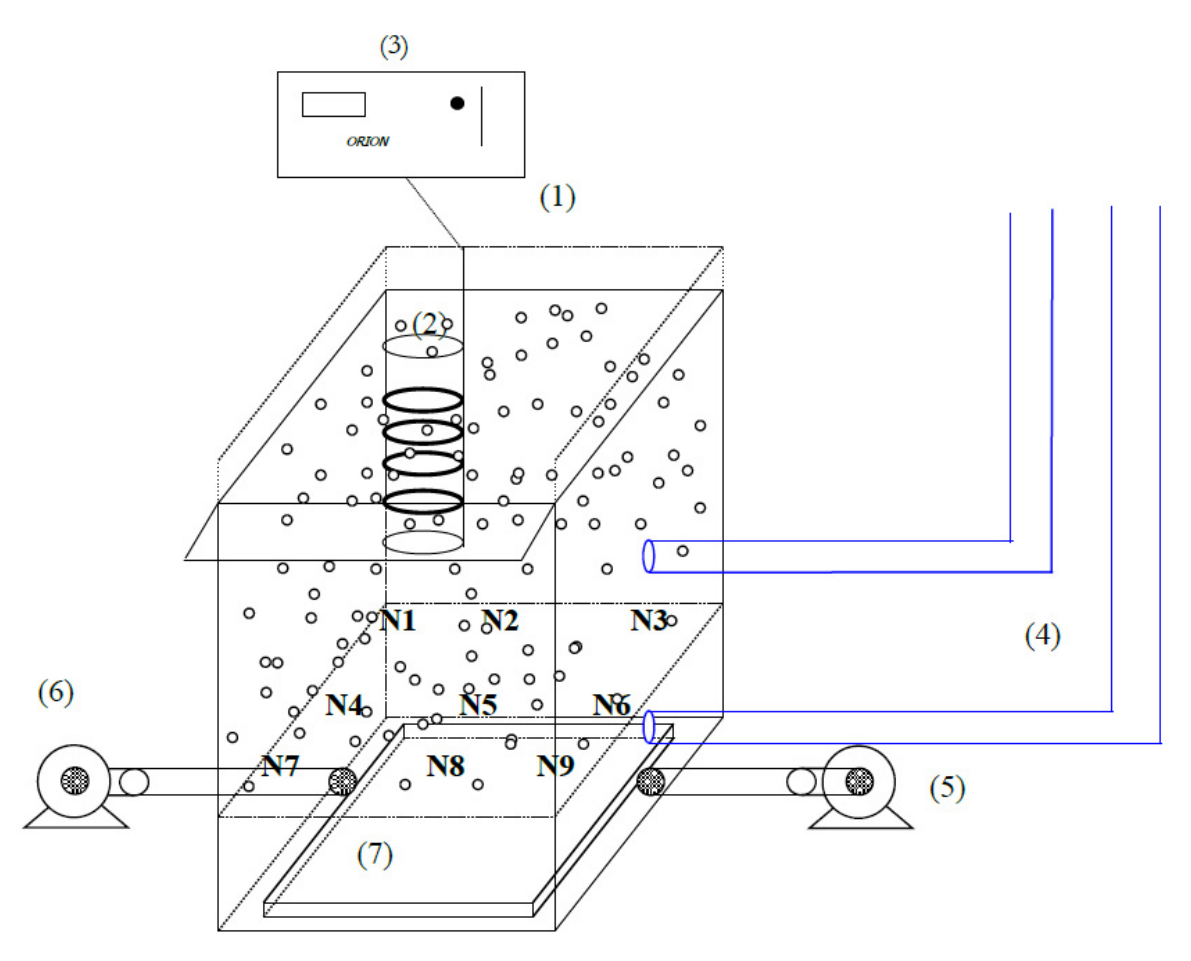
Figure 1. Schematic representation of the flotation device: (1) Cell, (2) Electrical conductivity flow cell, (3) Conductivity meter, (4) Manometers, (5) and (6) Peristaltic pump feed and tailing, respectively, and (7) Flat sparger.